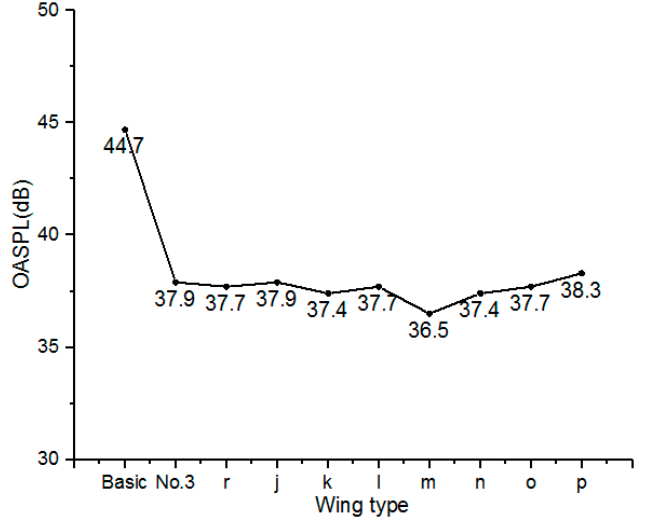
Figure 7. Overall sound pressure levels of different bionic wings.